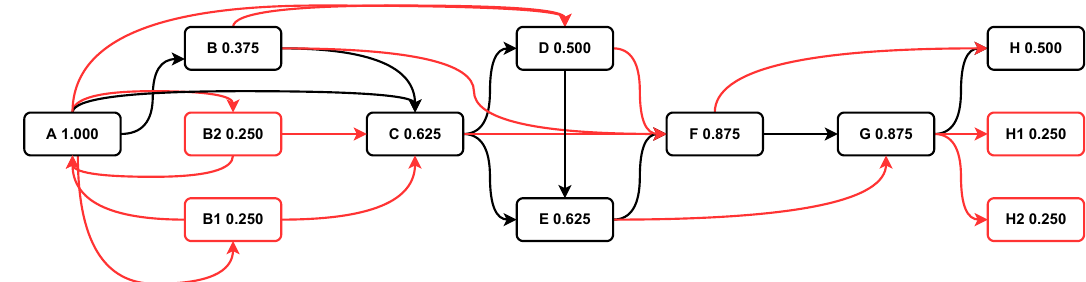
Figure 2. Process model discovered from redundant event log L 2